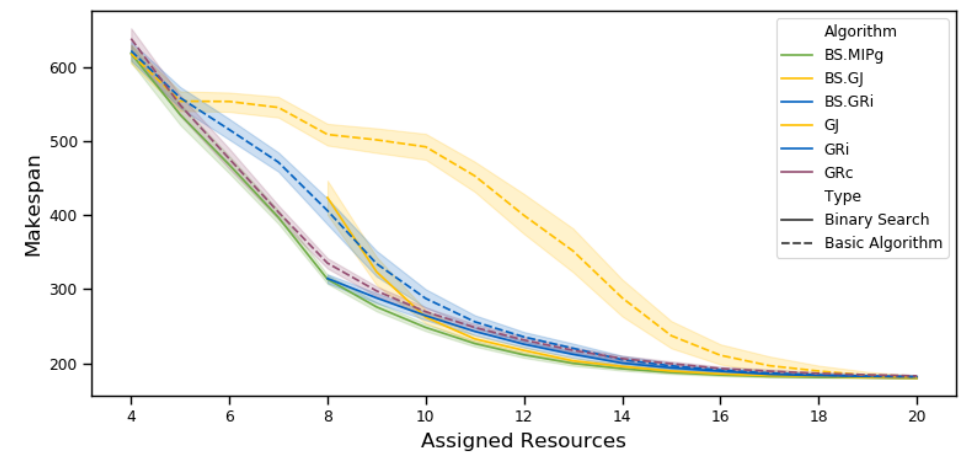
Figure 8. Median Pareto frontier over 100 instances with 95% confidence intervals. Algorithm ( BS.MIP g ) computes Pareto optimal solutions, whereas the other algorithms have no optimality guarantee. By design, Algorithms ( BS.GJ ) and ( BS.GR i ) cannot compute any solution using less than eight transporters.